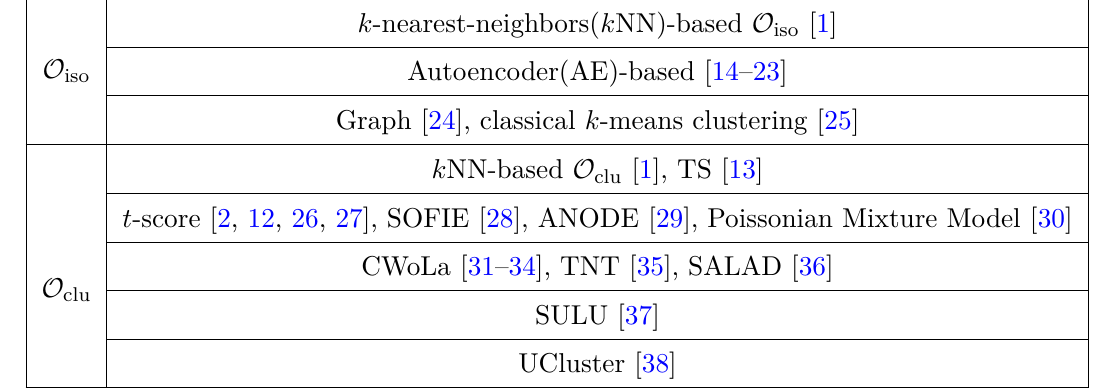
used to obtain different distributions for the events following different topologies. Recently the authors of ref. [25] studied anomalous jets at LHC which are far from the background clusters, using the distance of each testing event to the cluster centroids as a